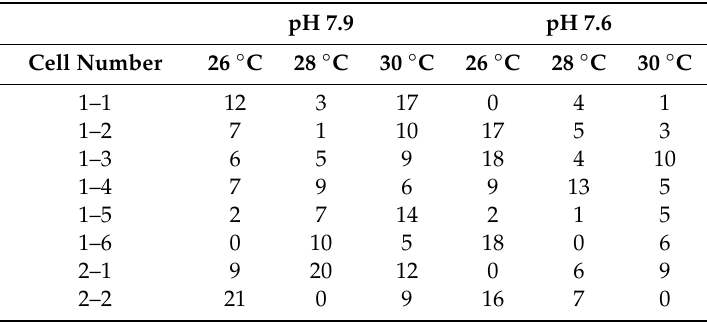
Figure 3. Egg production rate of the adult female copepod Acartia ohtsukai when maintained under two different pH and three different temperature conditions. Table 2. Number of eggs per Acartia ohtsukai female in water temperature and pH